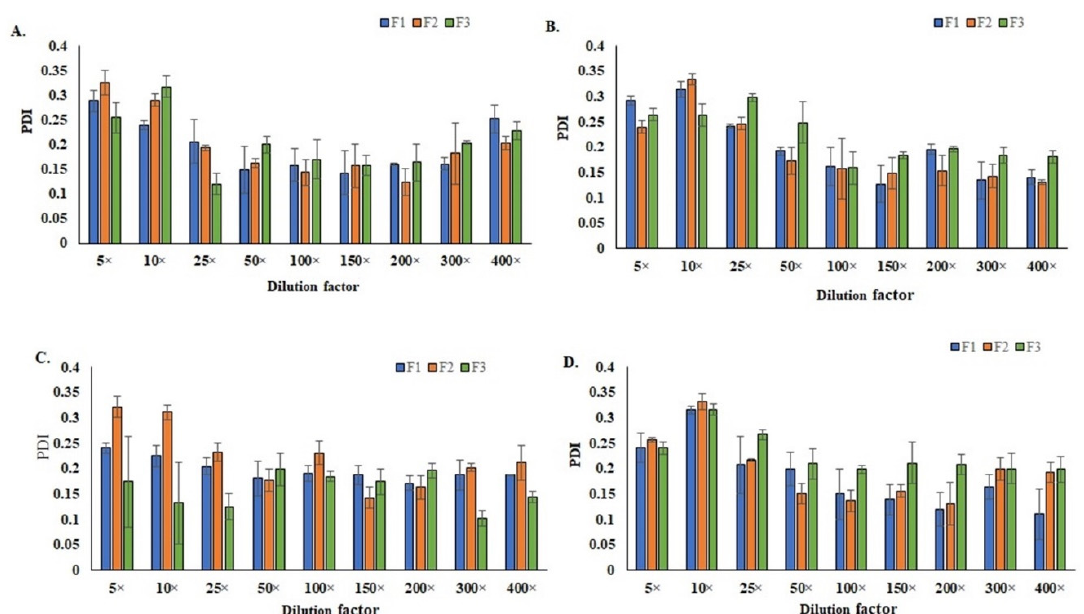
Figure 4. Effects of the dilution and buffer pH on the PDI of SEDDS ( A ) pH 5.5, ( B ) pH 6.5, ( C ) pH 7.4, and ( D ) pH 8.5.